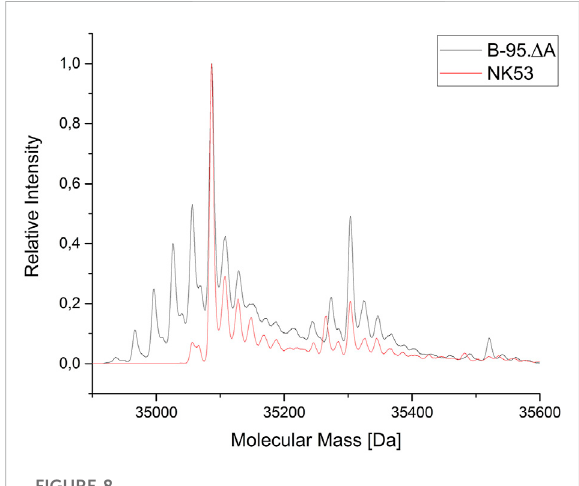
FIGURE 8 Mass spectrometric pro fi le (ESI-MS deconvolution) of proteins produced in the E. coli B-95. Δ A NK53 strain with attenuated nitroreductase activity compared to its progenitor strain. ELP(5x m - o NB-Dopa)-sfGFP produced by progenitor strain B-95. Δ A (grey) indicates the reduction of several ncAA nitro groups. See Section 3.3 for detailed peak annotation of reduced protein species. Expected intact protein mass for fi ve intact m - o NB-Dopa moieties = 35087.1 Da. Observed mass: 35086.9 Da. Expectedmassuponnitrogroupreductionatonesite:35057.1 Da. Observed mass: 35057.5